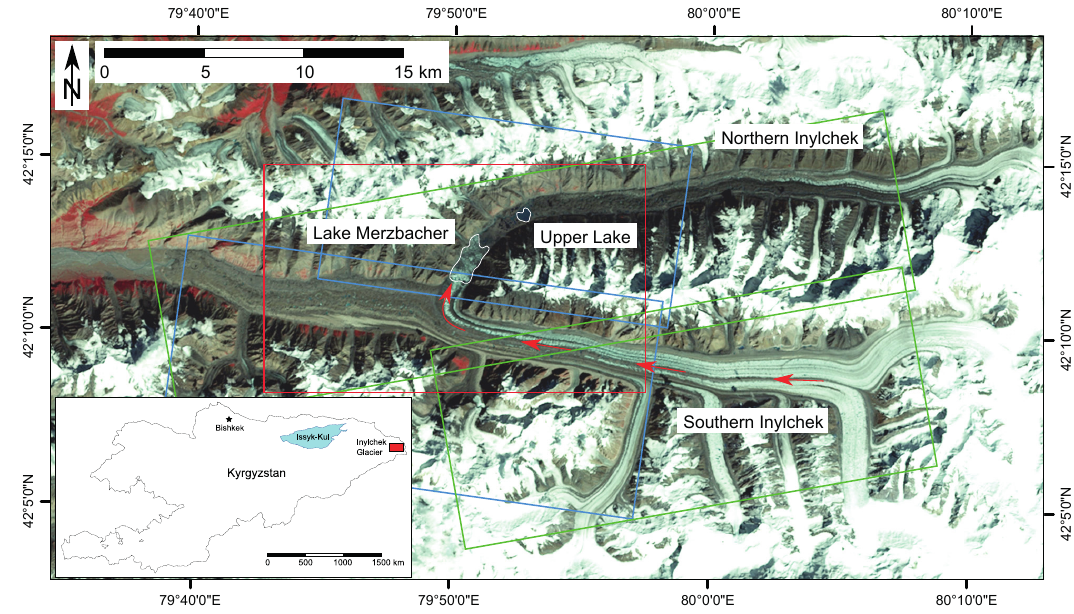
Figure 1. Northern and Southern Inylchek Glacier on a Landsat Thematic Mapper (Landsat TM) image from 24 August 2007. The main flow direction of the southern branch is marked by red arrows. The two lakes—Lake Merzbacher and the Upper Lake—are contoured by a white line. The location of the TerraSAR–X data frames are highlighted in green (ascending) and blue (descending) rectangles. The study area refers to the overlapping region and is outlined by a red rectangle. The inset shows the location of the Inylchek glacier within the country of